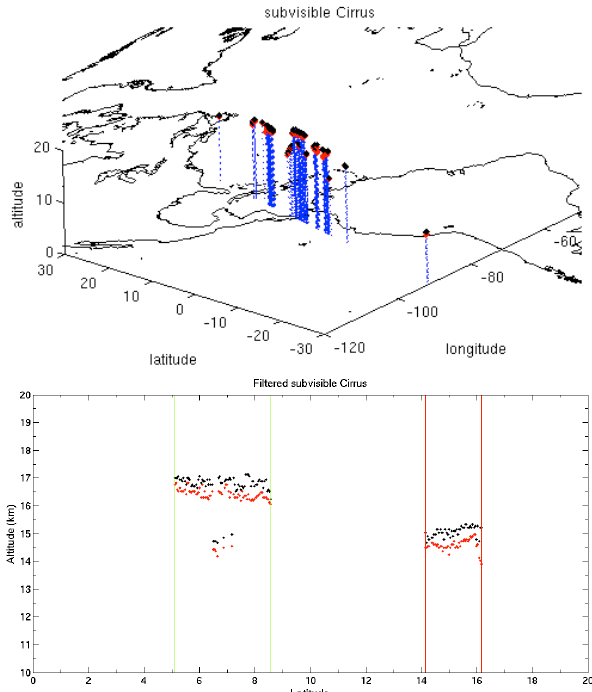
Fig. 1. (a) SVC detection along CALIPSO orbit (top) on 6 August 2007 (orbit T07-03-58ZN). Vertical profiles are shown in blue, SVC detections appear in black (cloud top) and red (cloud base). (b) Al- titudes of SVC clouds remaining after layer filtering based on hori- zontal extent and temperature (bottom) as a function of